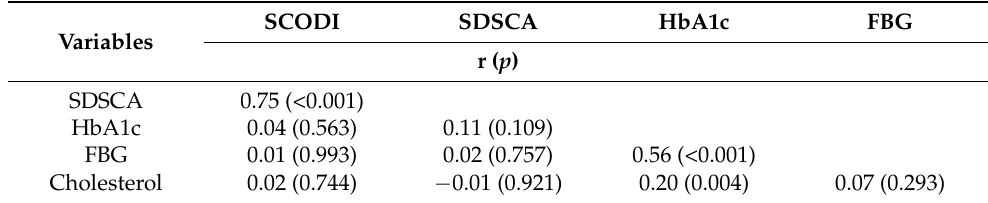
Table 4. Criterion-Related and Concurrent Validity of SCODI-K ( N = 210).